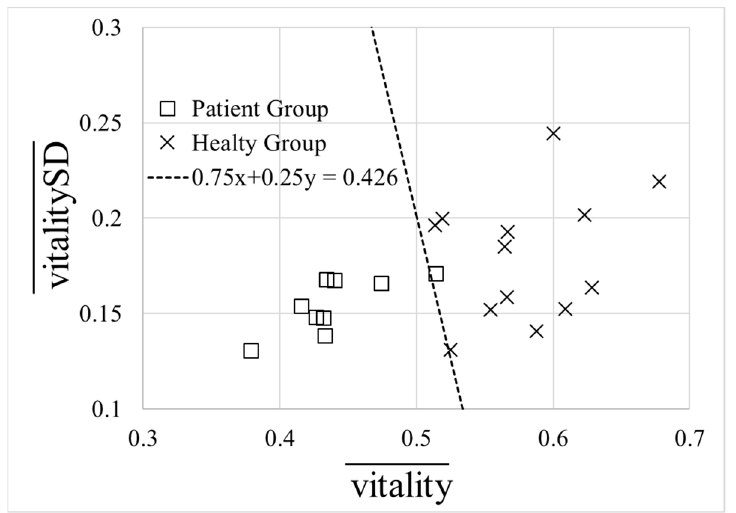
Figure 2. Scatter plot of mean vitality and the mean standard deviation of vitality for each participant (N = 22).